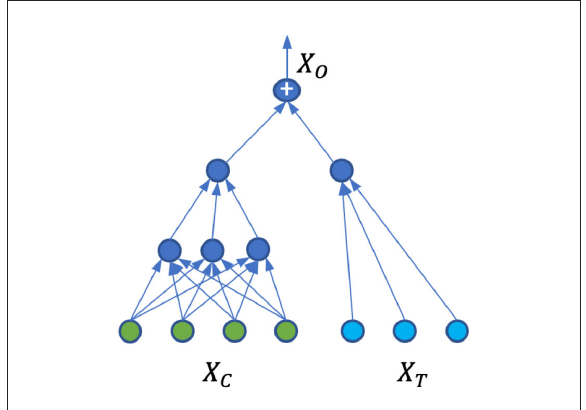
FIGURE1 Neural network architecture for patient outcome generation and causal effect